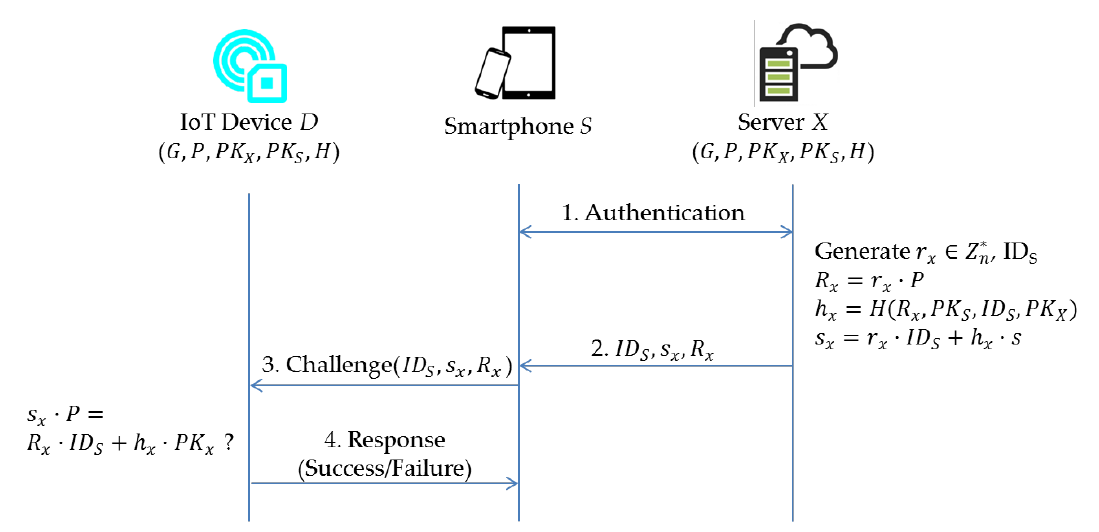
Figure 4. The communication processes of the proposed ECC-based scheme.